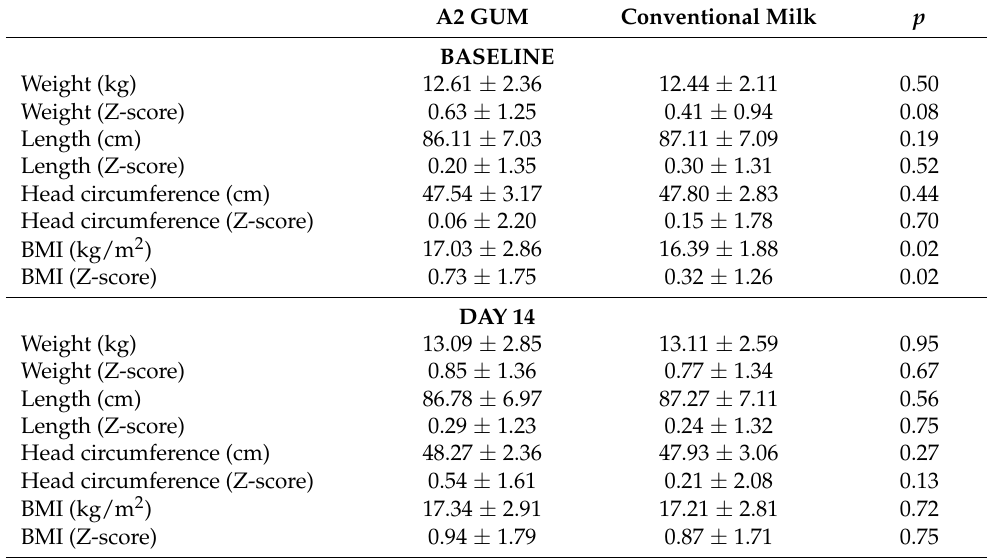
Table 4. Anthropometric parameters at baseline and day